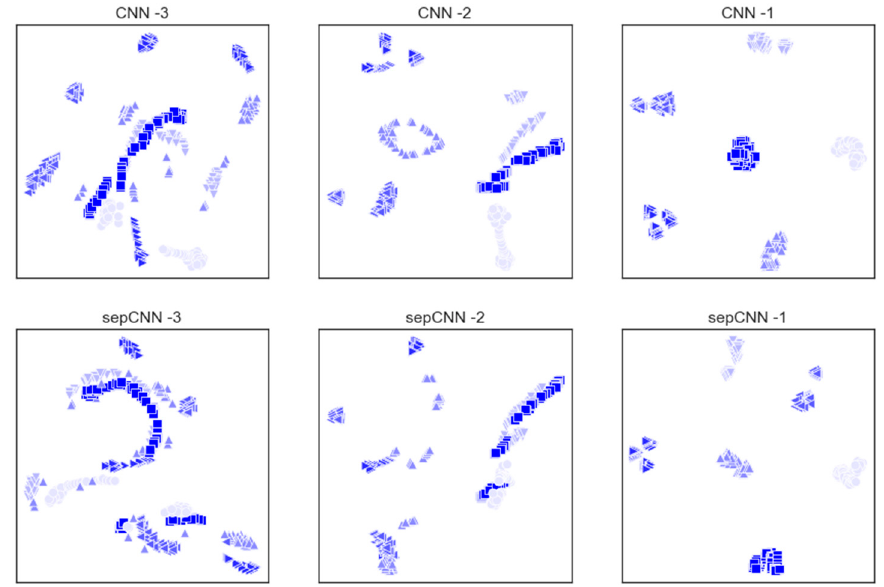
Figure 4. T-distributed stochastic neighbor embedding (t-sne) analysis of the last outputs of the CNNs used in transfer learning. The parameters of the best CNNs (Table 1) were frozen except for the last block of convolutional layers (trainable block, Figure 3). After training on the training set containing the gait data of six previously unseen individuals (4050 segments), the fine-tuned CNNs were fed with the test set (450 segments). The flattened outputs of the last convolutional layers (labeled-1, -2 and -3) were analyzed through t-sne to highlight the separation of the features. Note that the -3 output corresponds to the output of the non-trainable part of the CNNs. Marker style and brightness correspond to the six individuals.